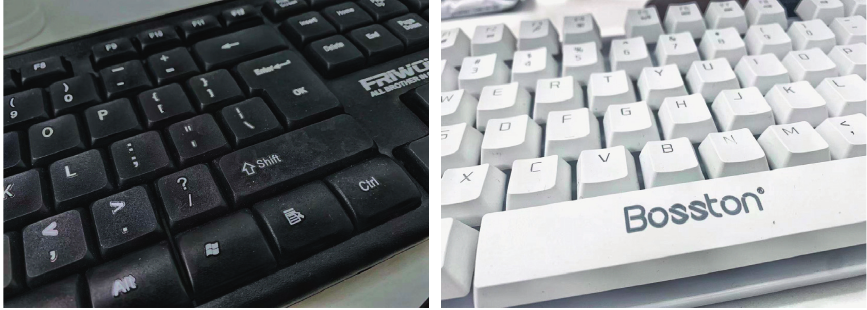
Figure 3: Plastic special-shaped membrane